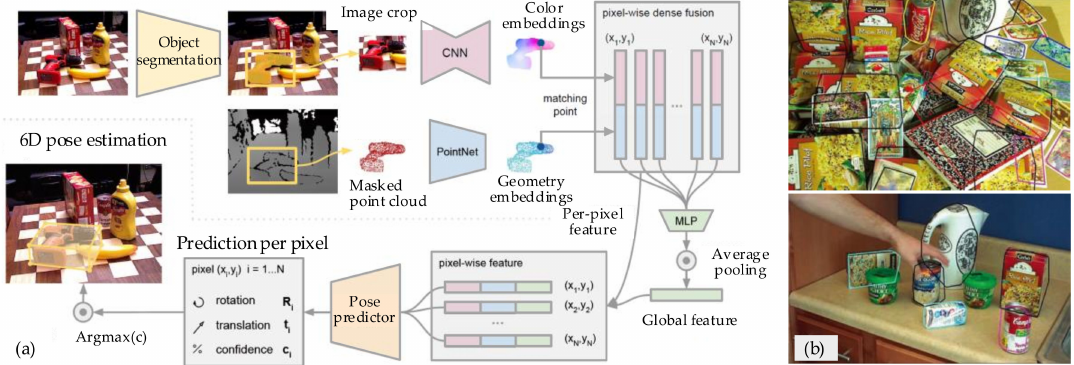
Figure 13. Approaches for pose estimation: ( a ) the DenseFusion architecture [113], ( b ) recognition based on the multi-object pose estimation and detection (MOPED) framework